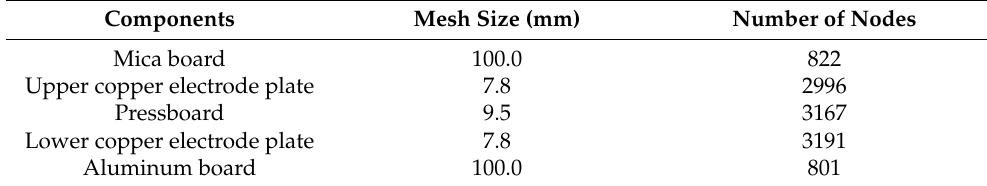
Table 3. Meshing information in the finite element model of the pressboard vibration. Components